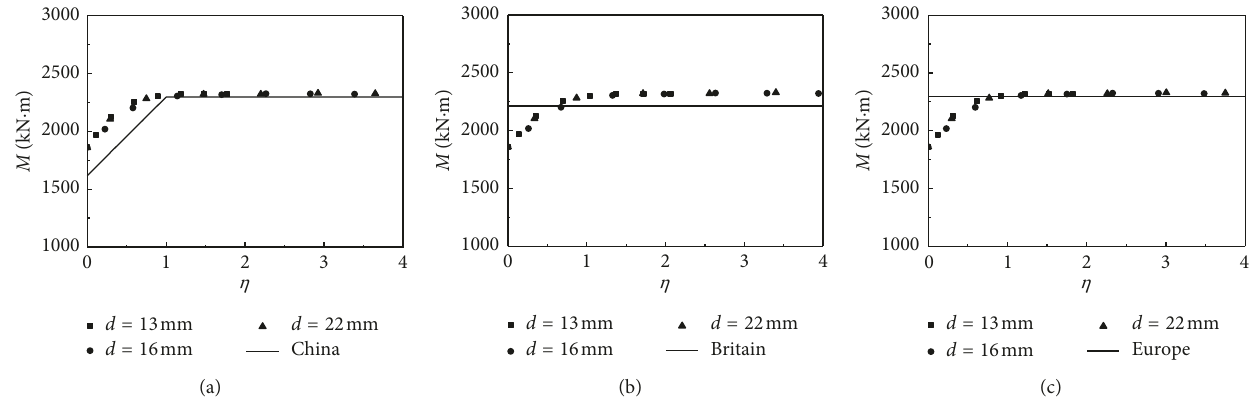
Figure 15: Influence of the stud diameter on M - ç relationship: comparison between the results of (a) GB 50017 and FEA, (b) BS 5950 and FEA, and (c) Eurocode 4 and FEA.